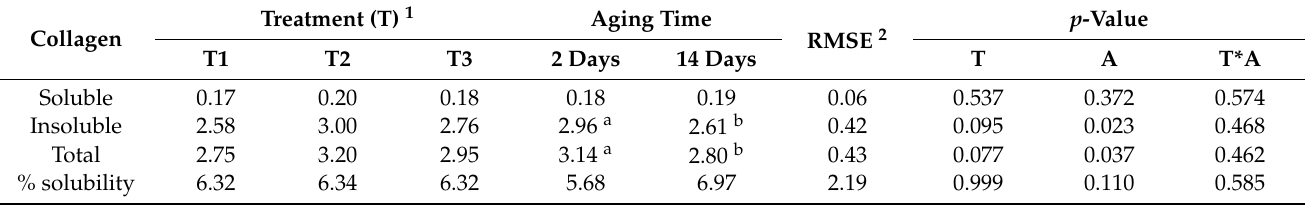
Table 3. Effect of dietary-energy-density treatment (T) 1 and aging time (A) on soluble, insoluble, and total collagen contents (mg/g wet weight) and collagen solubility (%) in Longissimus thoracis muscle of native Thai